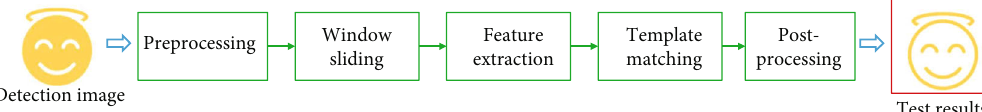
Figure 1: Schematic diagram of the target detection method based on template